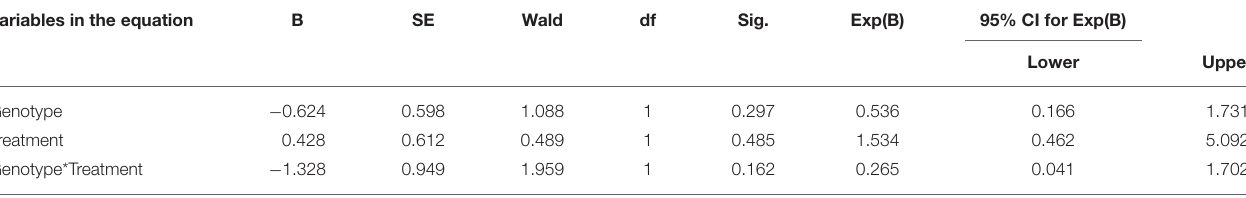
Variables in the equation B